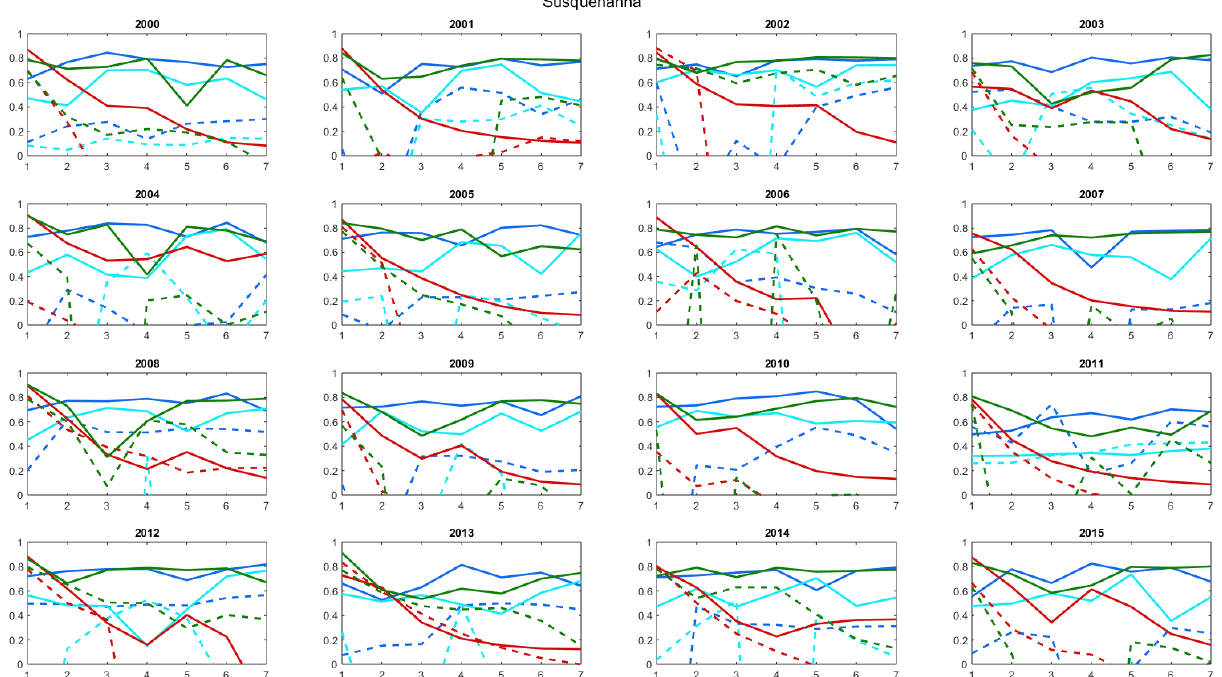
Figure 8. Evolution of NSE across the 7-day forecast window for the Susquehanna watershed. The training step is in full line, while leave-one-out validation is in dotted line. QP results are represented in red, SMP in blue, dSMP in cyan, and QSMP in green. Each subplot corresponds to a specific step of our cross-validation approach with the year used in validation in